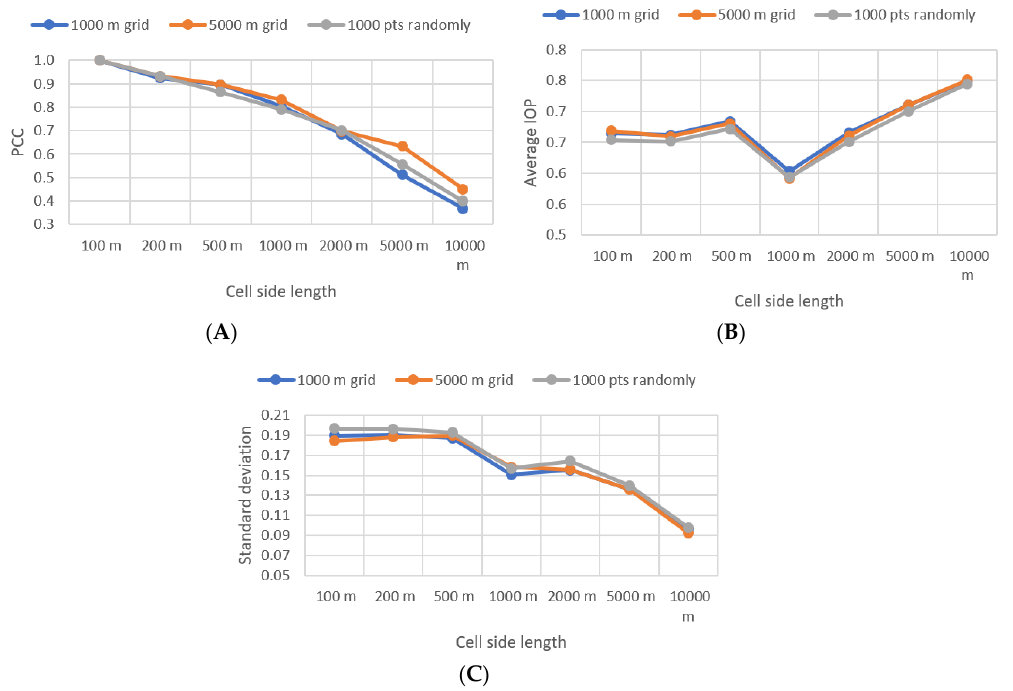
Figure 15. Correlation between the values of statistical parameters and cell size. ( A ) Correlation between PCC and cell size (for 100 m fields); ( B ) Correlation between average IOP and cell size; ( C ) Correlation between standard deviation and cell size.